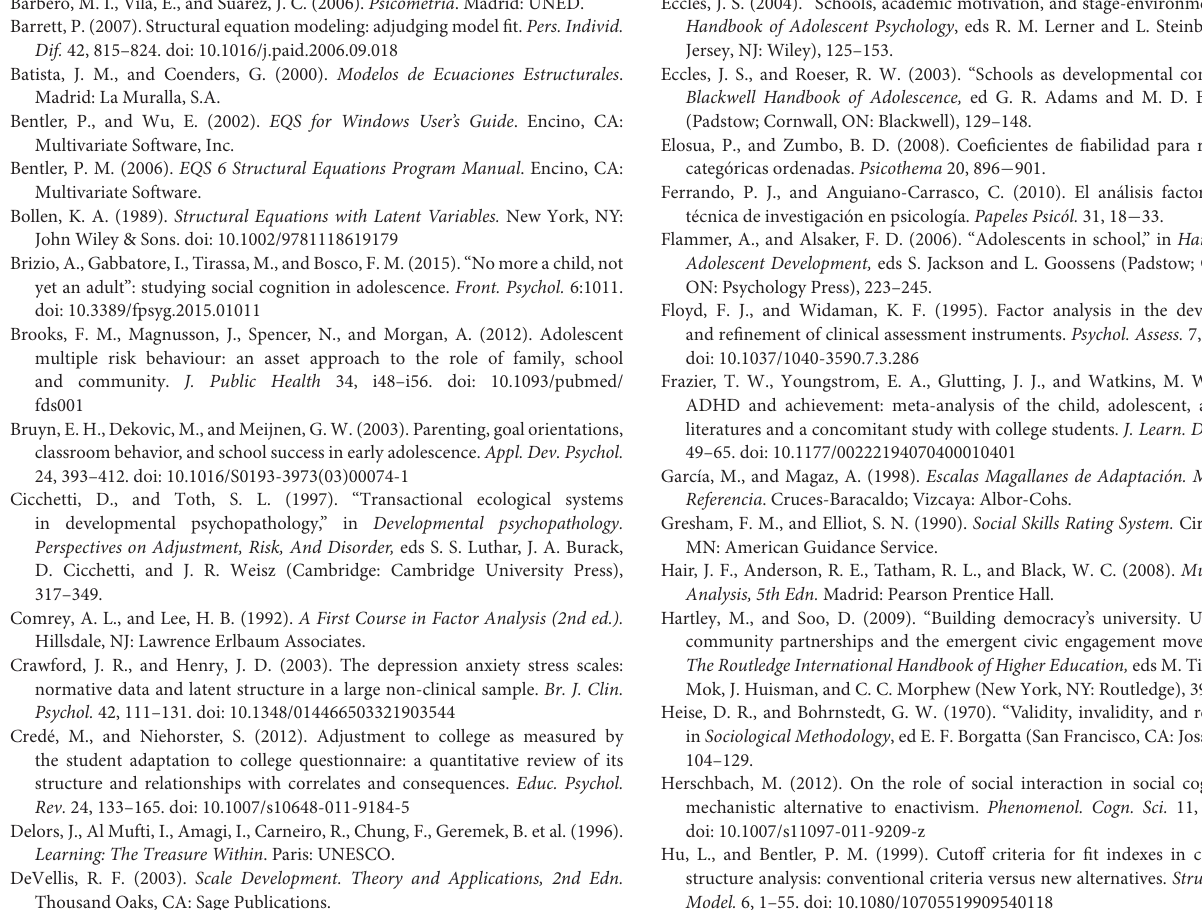
Referencia . Cruces-Baracaldo; Vizcaya: Albor-Cohs. Gresham, F. M., and Elliot, S. N. (1990). Social Skills Rating System. Circle